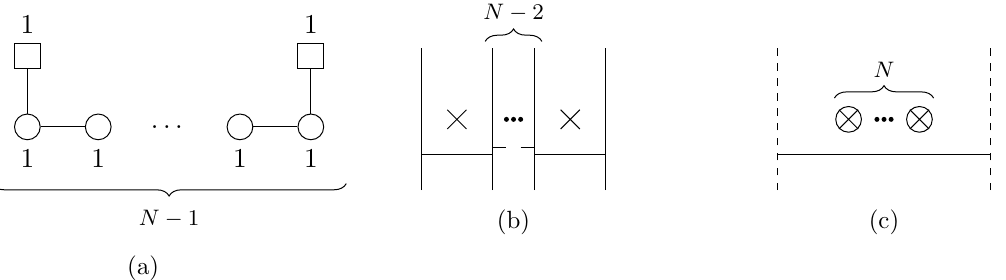
Figure 4. Mirror dual of 3 d N = 4 SQED with N (cid:13)avors. (a) Quiver. There are N (cid:0) 1 gauge nodes, with label n i = 1. (b) Coulomb branch brane con(cid:12)guration. There is a total of N NS5-branes. (c) Higgs branch brane